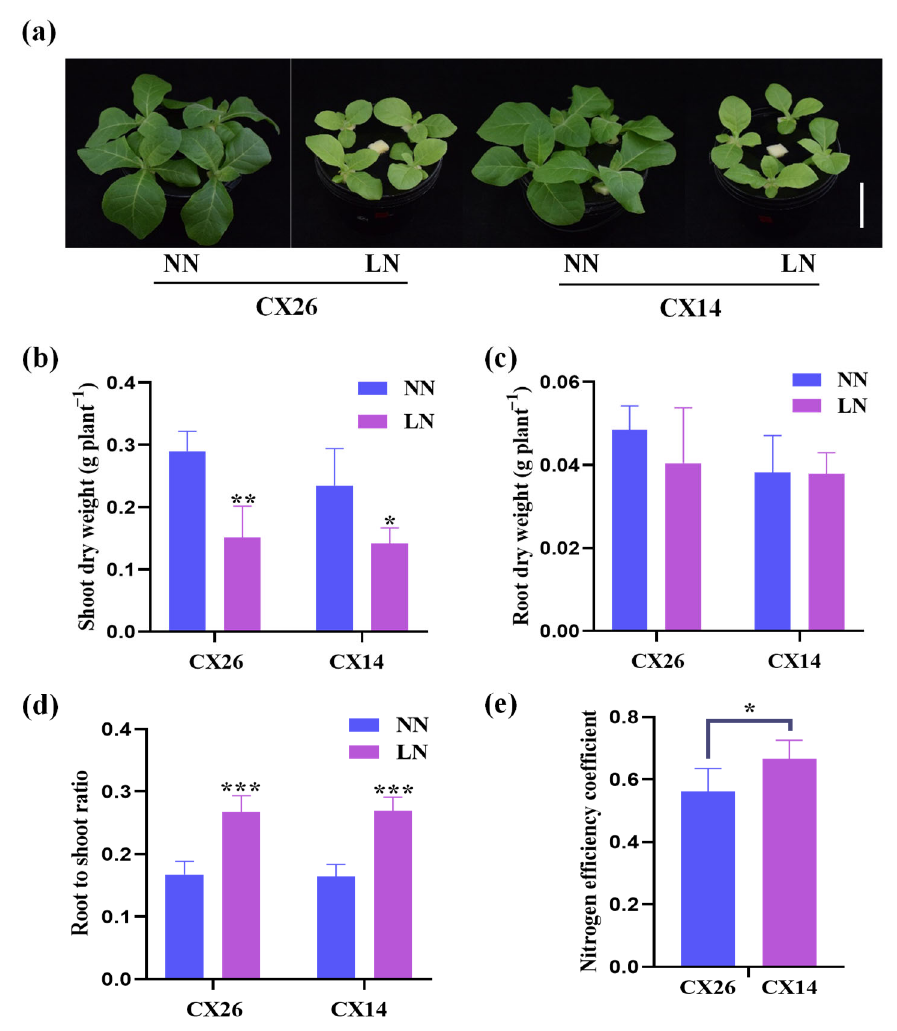
Figure 8. Growth responses of the two cigar tobaccos to two nitrogen levels: ( a ) growth performance of CX14 and CX26 under two treatments; ( b ) shoot dry weight; ( c ) root dry weight; ( d ) root/shoot ratio; ( e ) nitrogen efficiency coefficient. Data represents means ± SD ( n = 5). A significant difference between CX14 and CX26 under each treatment is indicated by Duncan’s method (* p < 0.05, ** p < 0.01, *** p <